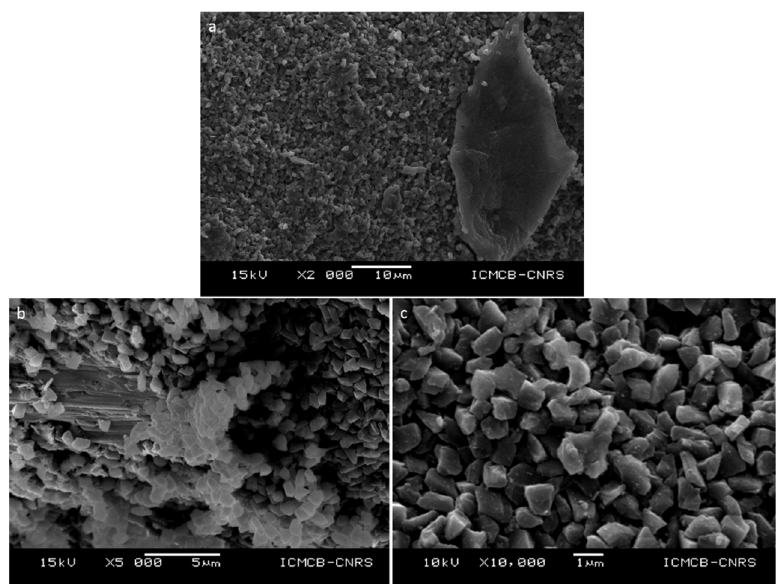
Figure 8. Microstructure of HP22-09-MS1 recovered sample observed in SEM (SEI, 15 kV , WD = 10 mm ) at different magnification (( a ) ×2000, ( b ) ×5000 and ( c ) ×10,000). First, there is no evidence for grain fracturation, nor the presence of other phases. There are two types of regions inside the samples ( a , b ), typically more or less sintered suggesting that densification is heterogeneous and not total ( a – c ). In more densified areas, a lot of grain boundaries are observed ( b ) whereas grains are only packed in less densified areas with only few grains that can be sintered (center of ( c ) for example).